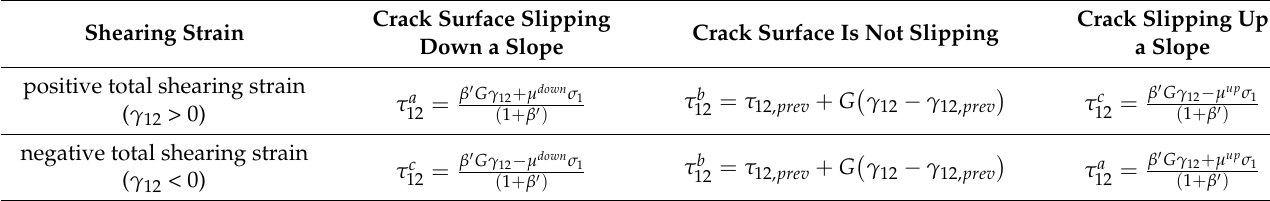
Table 1. Equations for compression across the